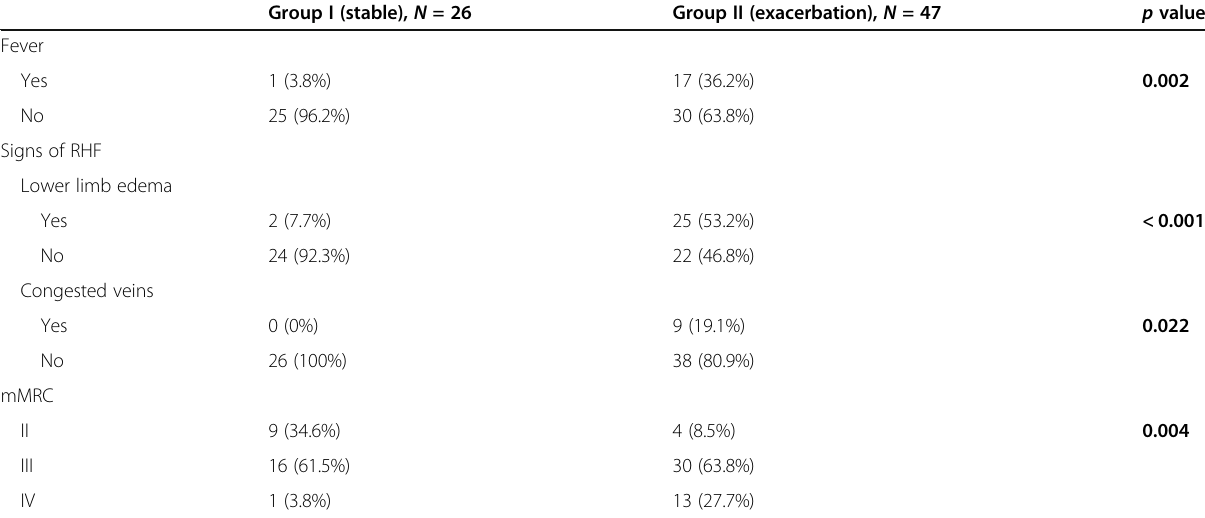
Table 2 Clinical characteristics of the diseased